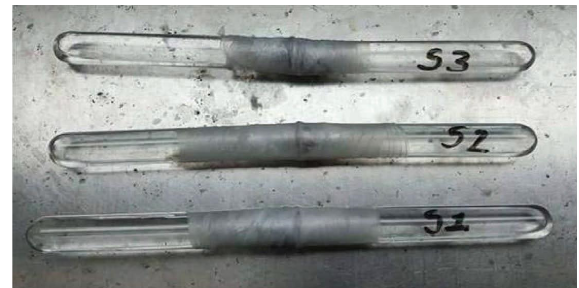
Figure 10: Te permeability test of the DFS scafold of diferent